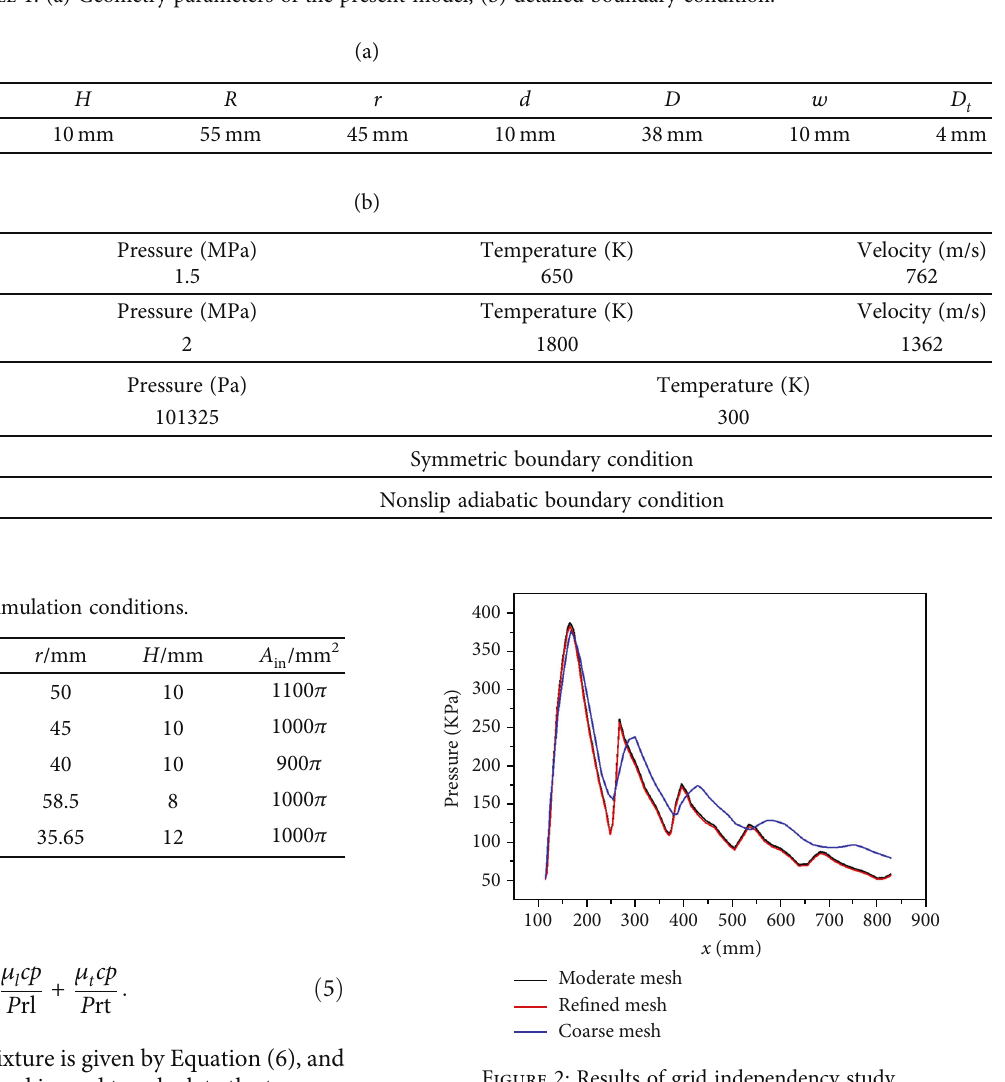
Table 1: (a) Geometry parameters of the present model; (b) detailed boundary